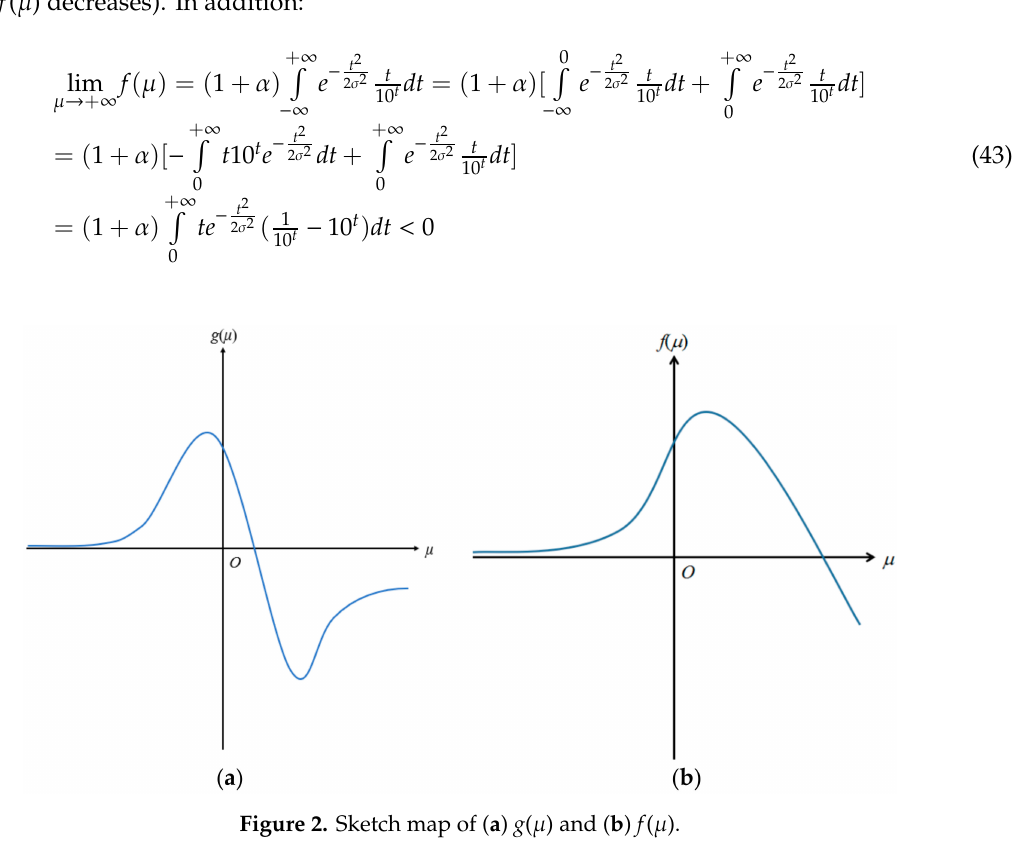
Figure 2. Sketch map of ( a ) g ( µ ) and ( b ) f ( µ